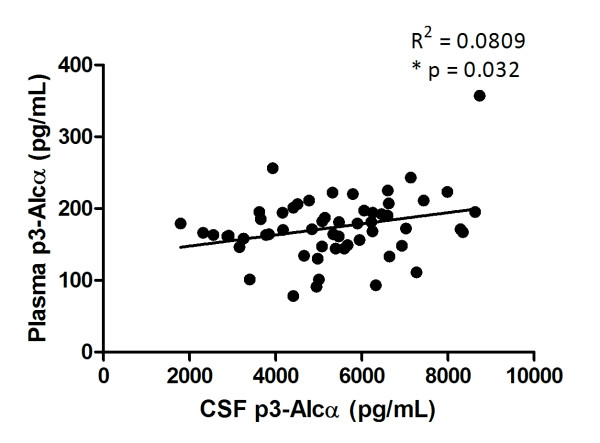
Positive correlation of p3-Alcαlevels in CSF with those in plasma of same subjects. Correlation of CSF p3-Alcα levels with plasma p3-Alcα levels were examined in same subjects of pre-clinical stages for dementia, whose MMSE score did not decrease remarkably (n = 57, Table 1). The relation between CSF p3-Alcα levels and plasma levels was investigated by Pearson's correlation coefficient test (Graph Pad Prism 5) (R2 = 0.0809; *p = 0.032).